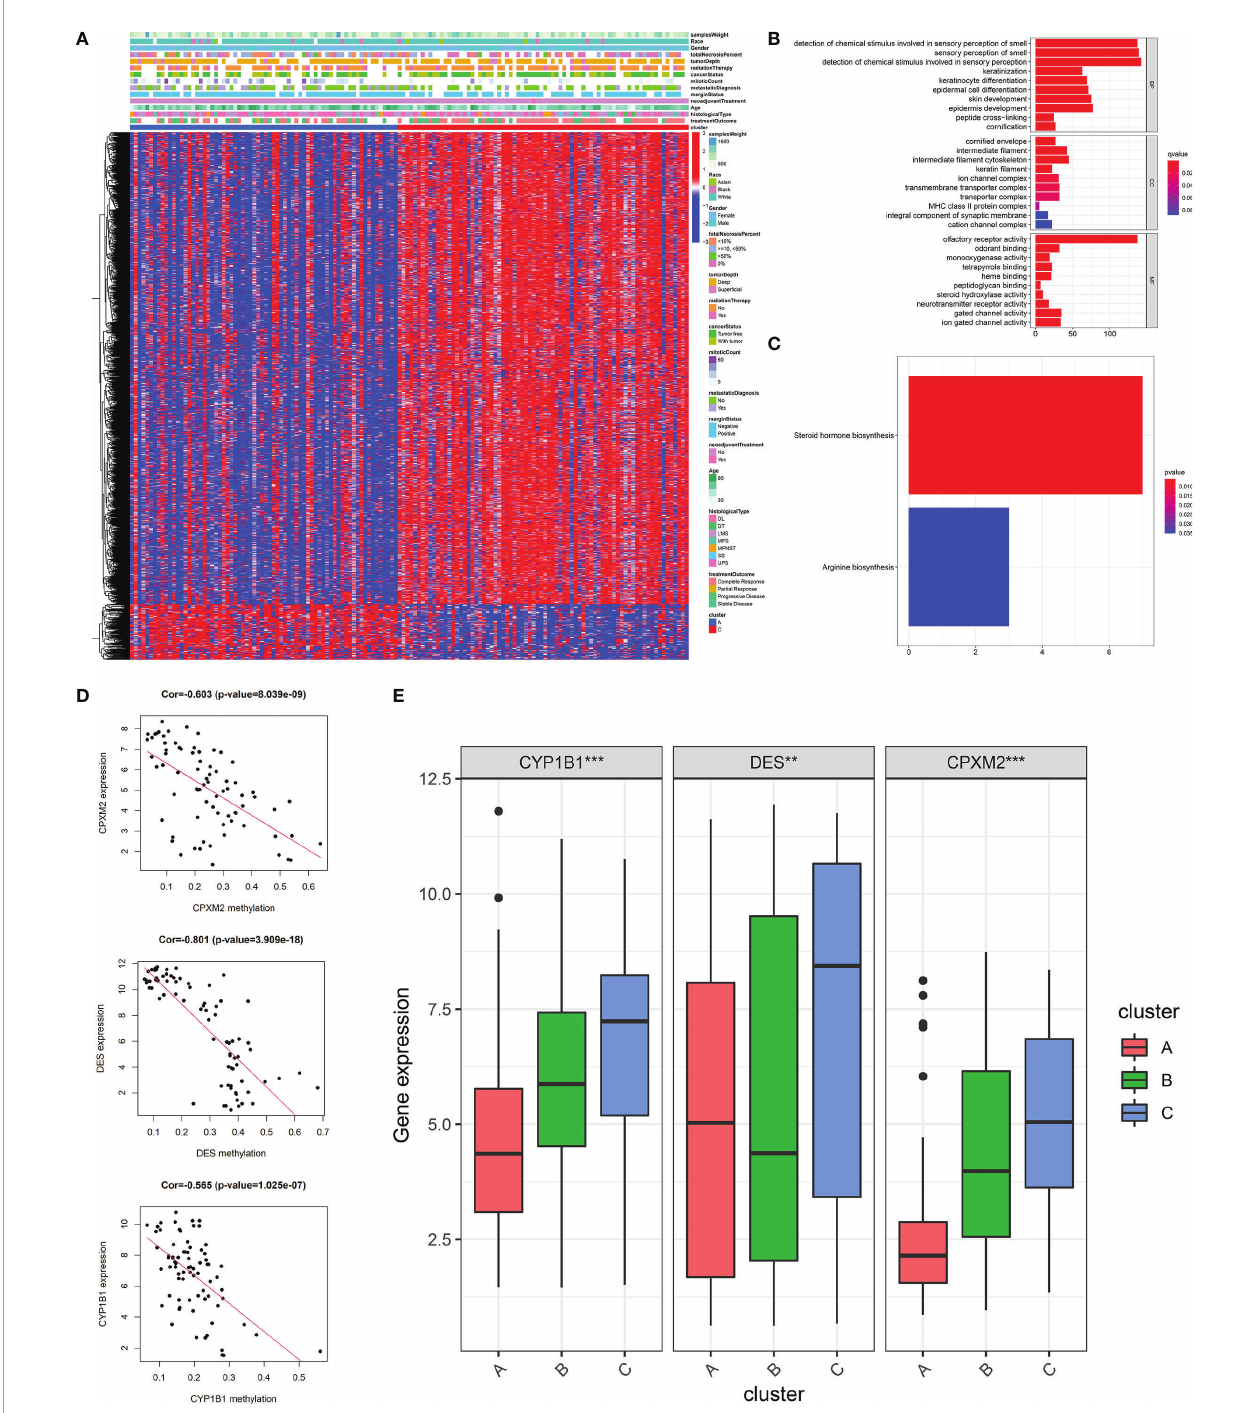
FIGURE 5 | DNA methylation analysis and the identi fi cation of stemness-related methylation-driven genes. (A) The heatmap of differential methylation sites between highest stemness (cluster A) and lowest stemness (cluster C). GO (B) and KEGG (C) analyses of genes with differential methylation sites. (D) The correlations of gene expression of three stemness-related methylation-driven genes with corresponding value of gene methylation. (E) The differences of stemness-related methylation- driven genes among three stemness subtypes. ***p < 0.001; **0.001 < p <